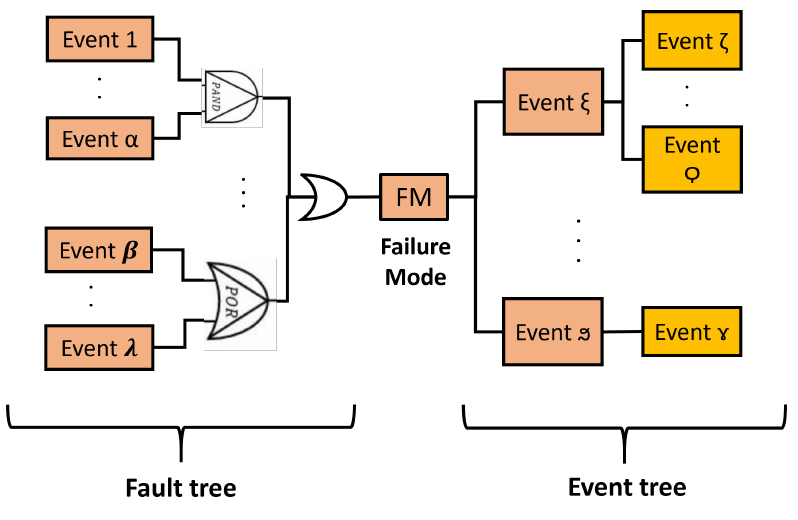
Figure 7. A Bow-Tie Diagram